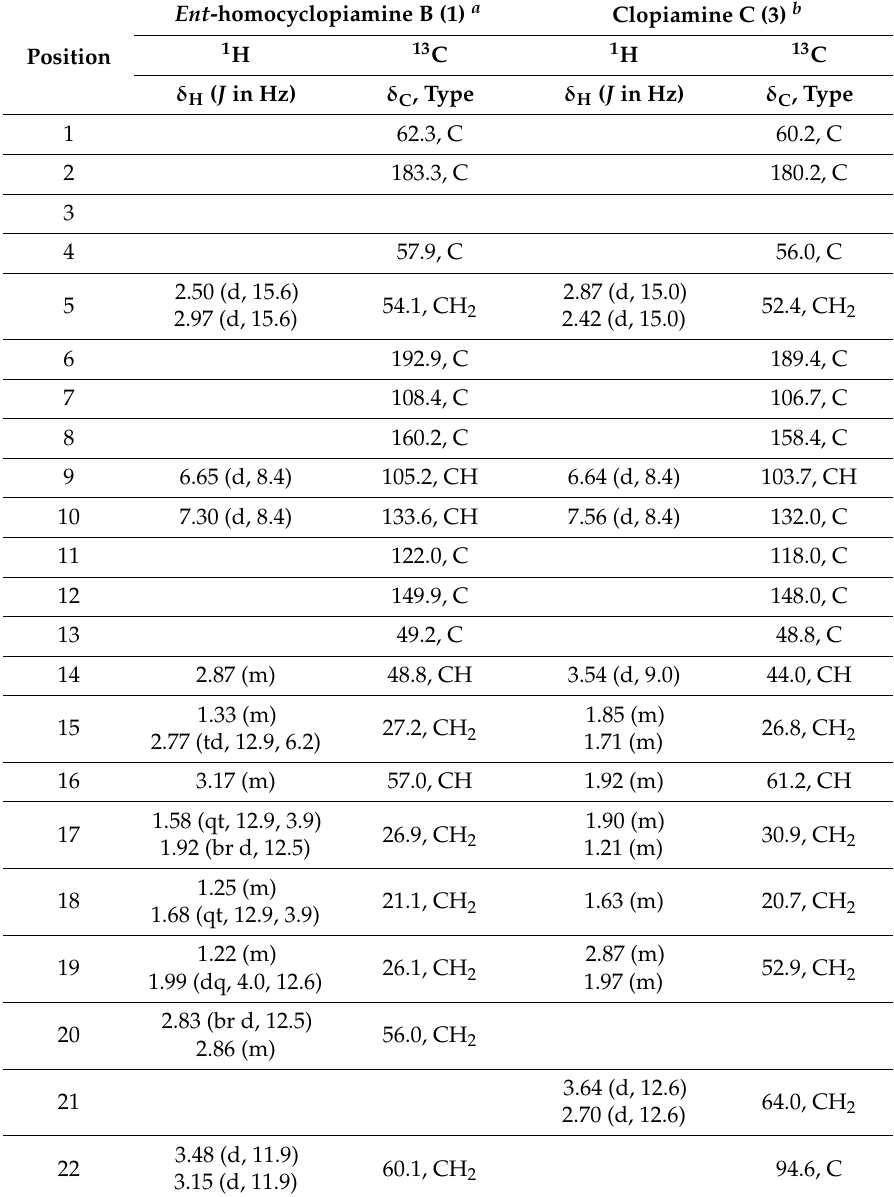
Table 1. NMR spectroscopic data for compounds 1 and 3